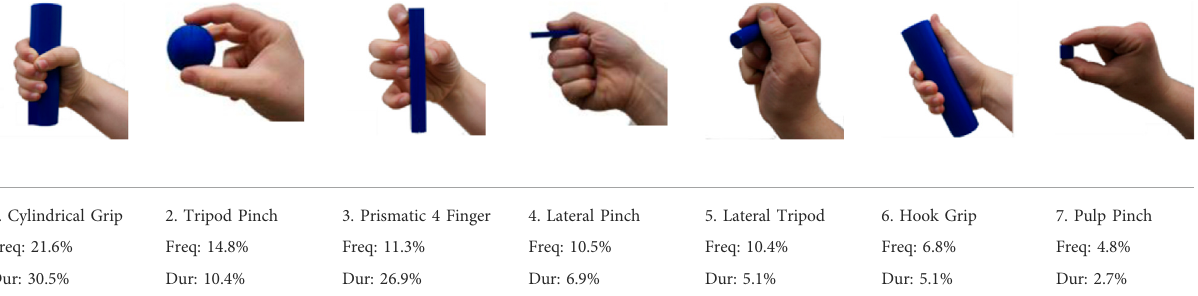
TABLE 2 Top seven generalized hand grasp con fi gurations, percent frequency (Freq), and duration (Dur).